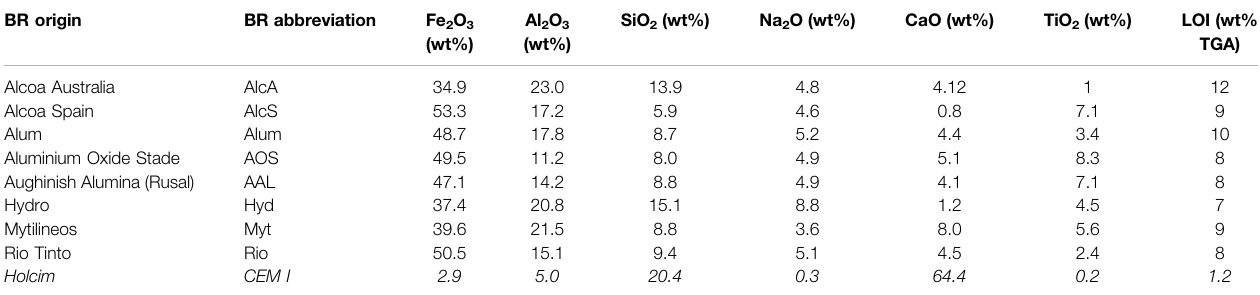
TABLE 1 | Chemical composition (major elements, > 1 wt%) of the bauxite residues determined by WD-XRF and loss on ignition by thermal analysis. The information of the Holcim CEM I as delivered by the supplier is added (this cement also includes 1.0 wt% MgO, 0.9 wt% K 2 O, and 3.1 wt% SO 3 ). BR